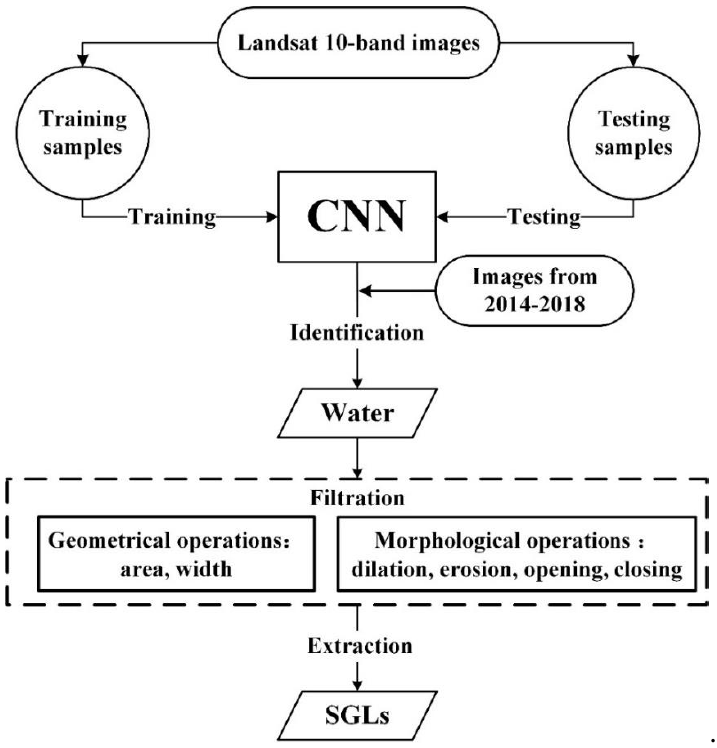
Figure 4. Flowchart of supraglacial lakes (SGLs) extraction.